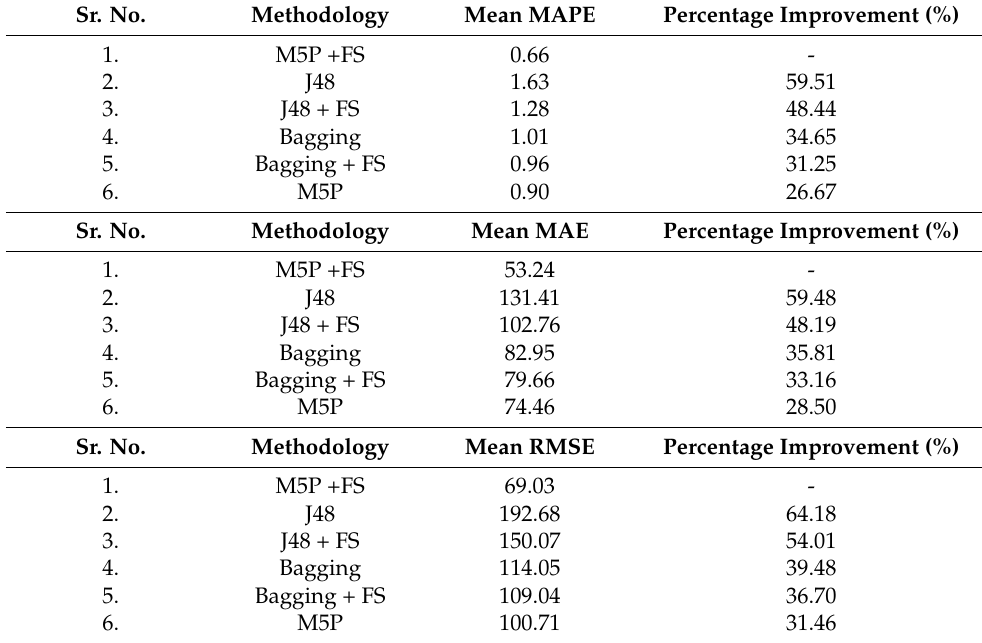
Table 6. Improvement of different performance measures using M5P + FS compared to other approaches for STLF. Sr.